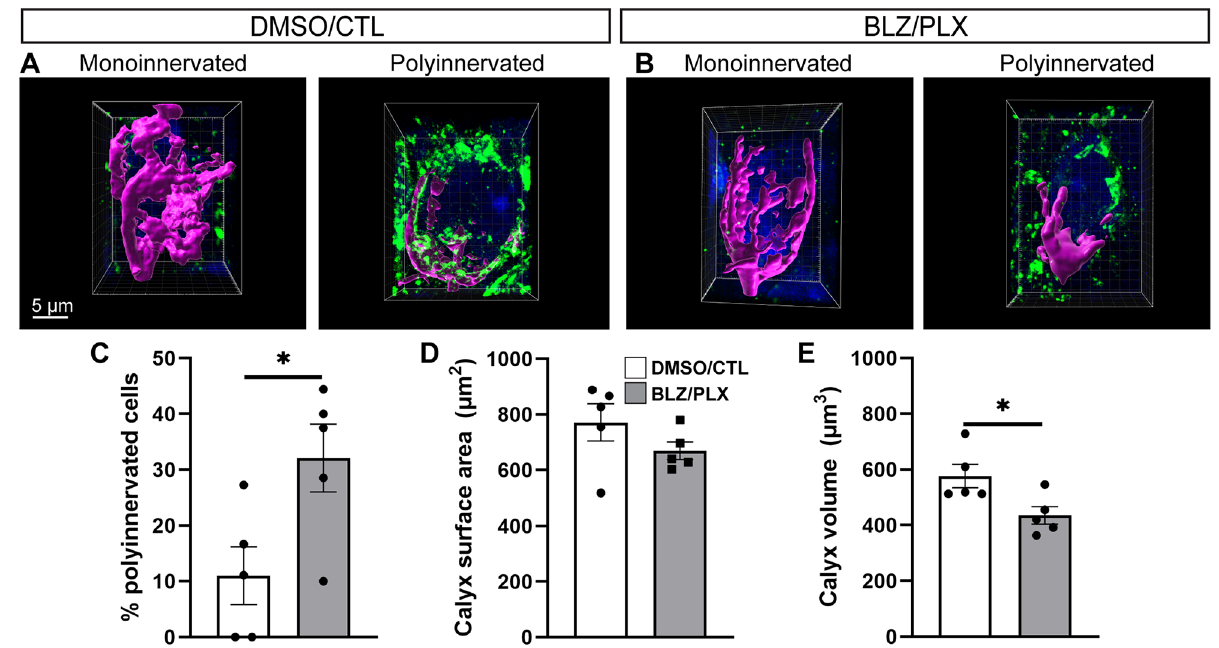
Figure 2. BLZ/PLX treatment disrupts calyceal elimination. ( A ) Mono- and polyinnervated MNTB neurons from a control mouse at 4 wk. 3D reconstructed rhodamine dye labeled calyx (magenta) and VGLUT1/2 (green) immunolabeling. ( B ) Mono- and polyinnervated neuron from a BLZ/PLX treated mouse at 4 wk. ( C ) Comparison of the percentage of polyinnervated versus monoinnervated cells in each treatment group showed that BLZ/PLX treatment results in more polyinnervated cells. ( D ) Surface area of the reconstructed calyces did not show a treatment-related difference. ( E ) Volume of the reconstructed calyces was lower in the BLZ/PLX treated group. * p < 0.05. Scale bar = 5 µm, applies to panels ( A ), ( B